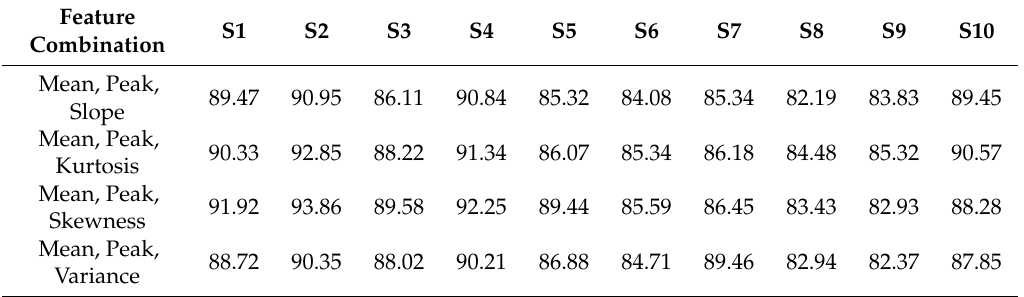
Table 2. The classification accuracies of the mean-peak feature combinations obtained from HbR signals.